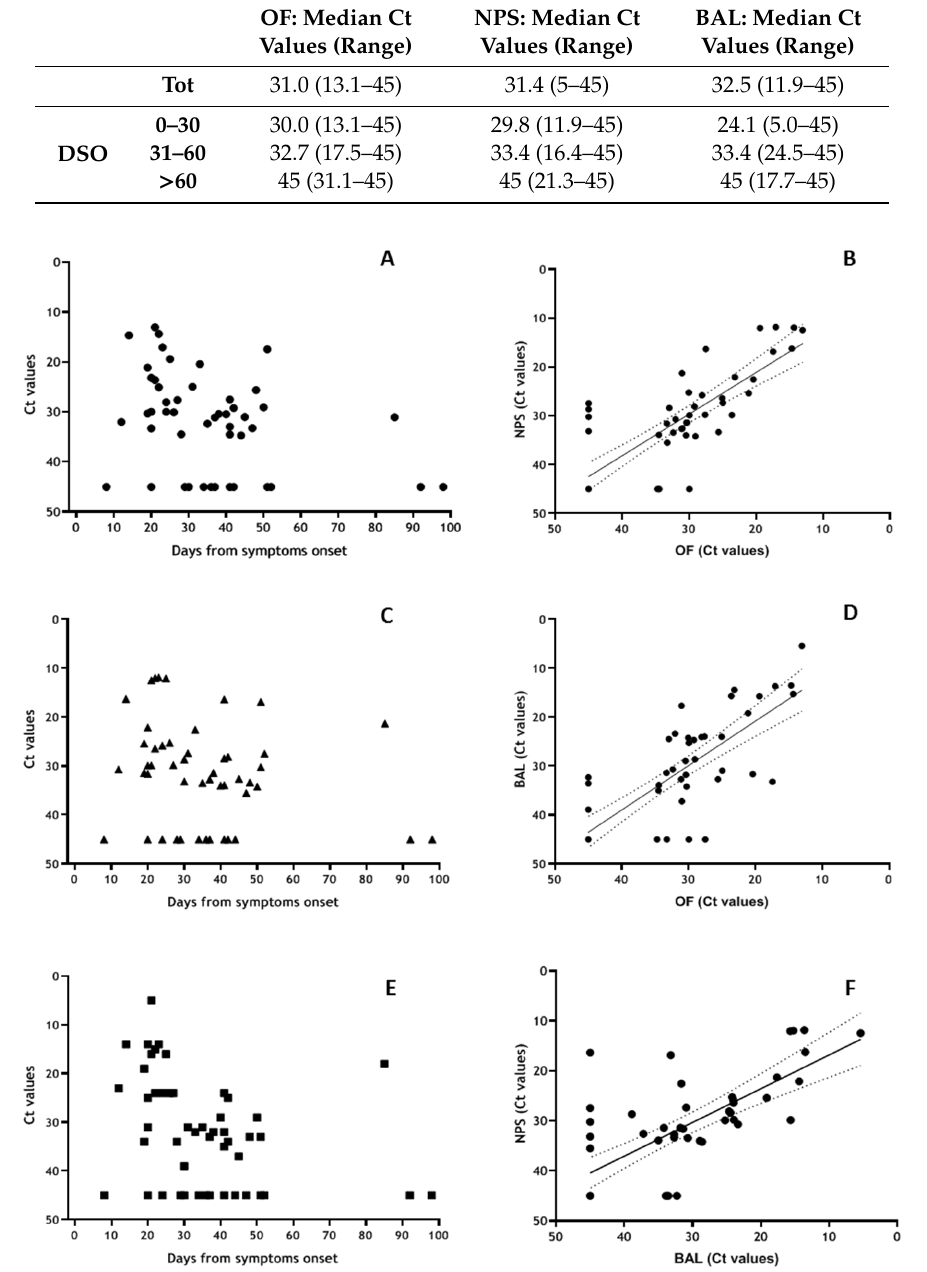
Figure 5. Shedding of SARS-CoV-2 RNA in OF, NPS and BAL samples based on data symptoms onset and correlation analyses. Results obtained from 50 samples coming from 12 patients with severe COVID-19 disease in the Intensive Care Unit, showing more severe presentation (PaO2 / FiO2 < 100) tested for the presence of SARS-CoV-2 RNA in OF (( A ), round symbol), NPS (( C ), triangular symbol) and BAL (( E ), square symbol) and expressed as Ct values vs days from symptoms onset. Correlation analysis from Ct values obtained from NPS vs OF ( B ), BAL vs OF ( D ) and NPS vs BAL ( F ).